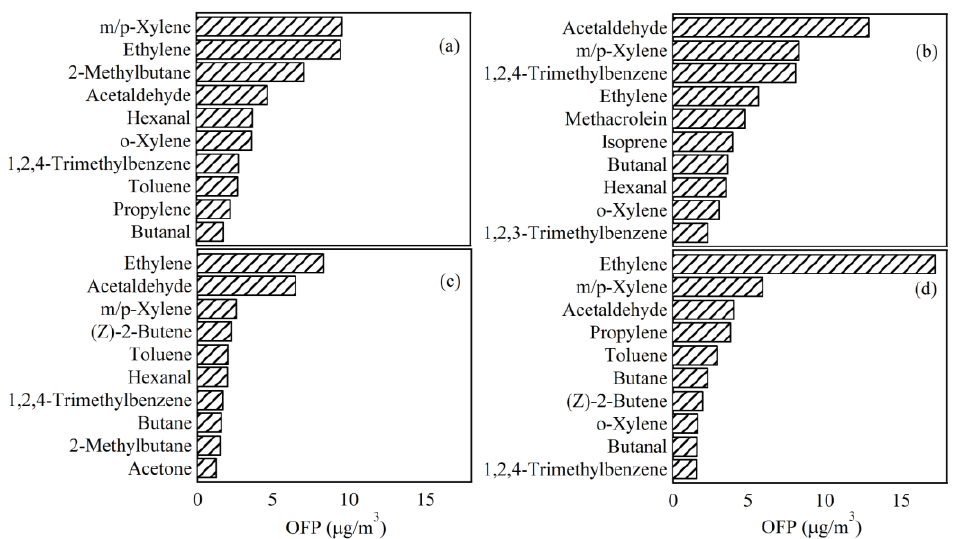
Figure 13. Comparison of five components of VOCs, OFP, L OH in ( a ) spring, ( b ) summer, ( c ) fall, and ( d ) winter.